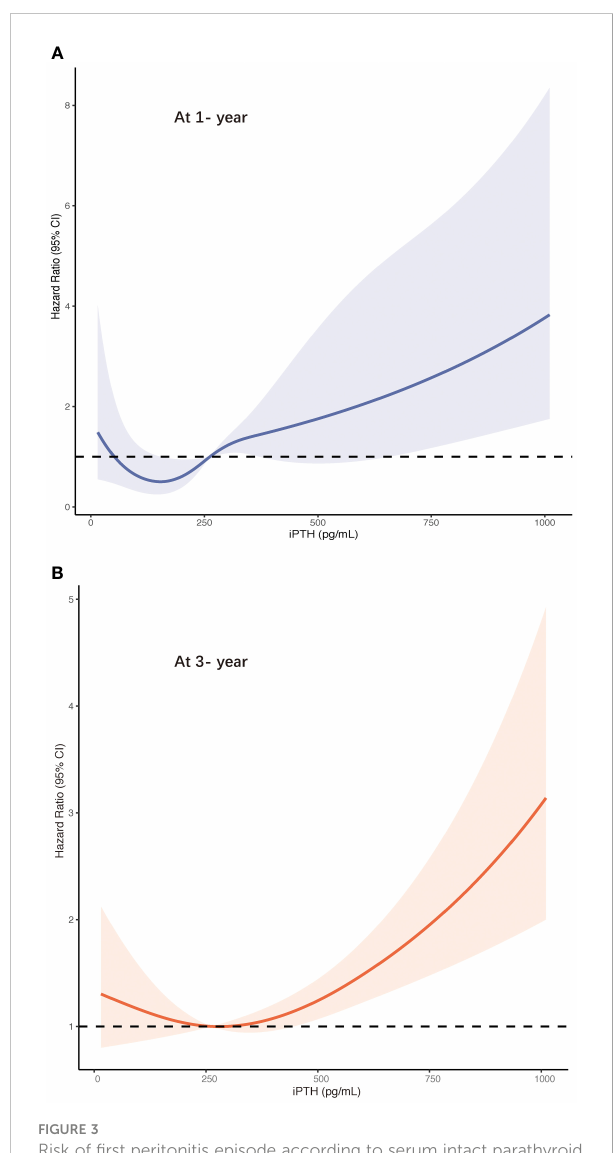
FIGURE 3 Risk of fi rst peritonitis episode according to serum intact parathyroid hormone ((iPTH) levels with the fully adjusted (model 5) restricted cubic spline models at 1 year (A) and at 3 years (B) . CI , con fi dence